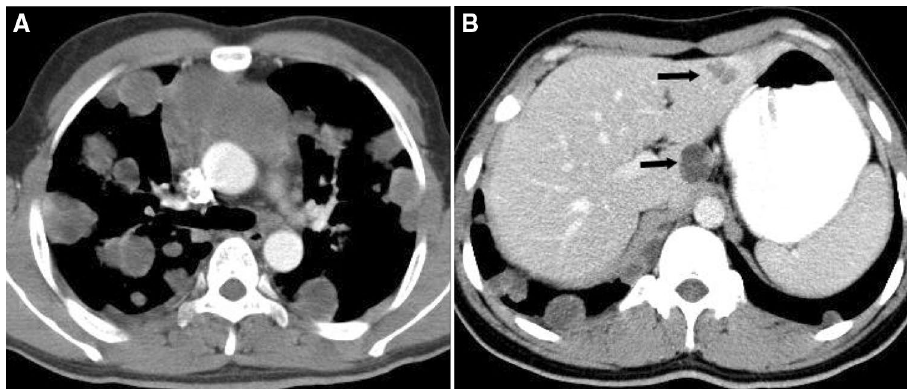
Figure 4. Thymic squamous carcinoma in a 27-year-old man withlung and liver metastasis. Contrast enhanced CT scan (Axial 5.0 mm) obtained at the level of the main bronchi ( A ) and the first porta hepatis ( B ) shows multiple metastasis in the bilateral lung and the left lobe of the liver (black arrow). This patient died 26.1 months since the first CT examination.